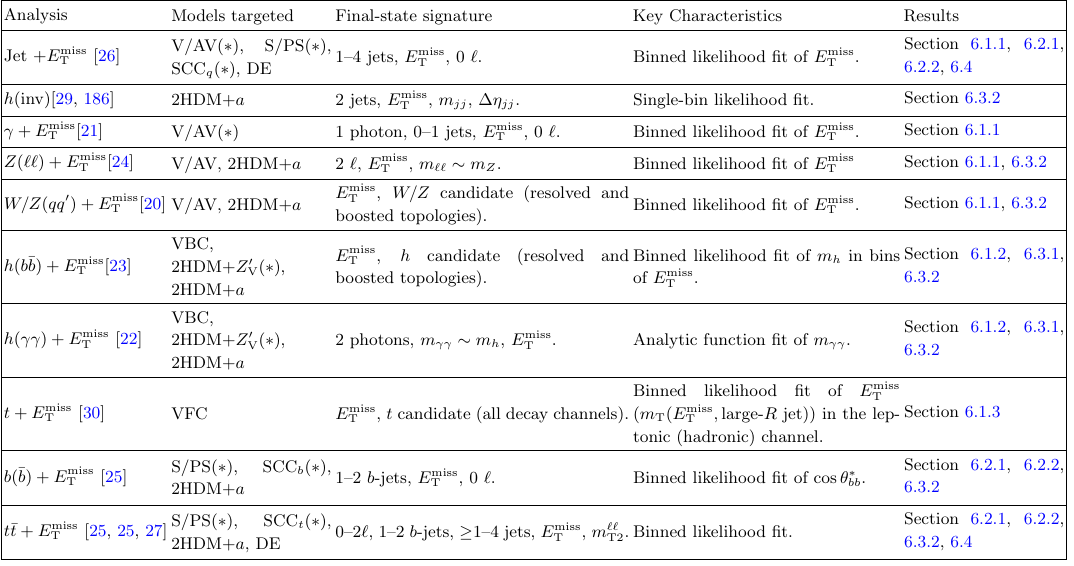
Table 2. Summary of searches for invisible (cid:12)nal states used to constrain the di(cid:11)erent DM models de(cid:12)ned in section 2. The ( ) indicates models which were presented in the original publication, all (cid:3) others are either new or